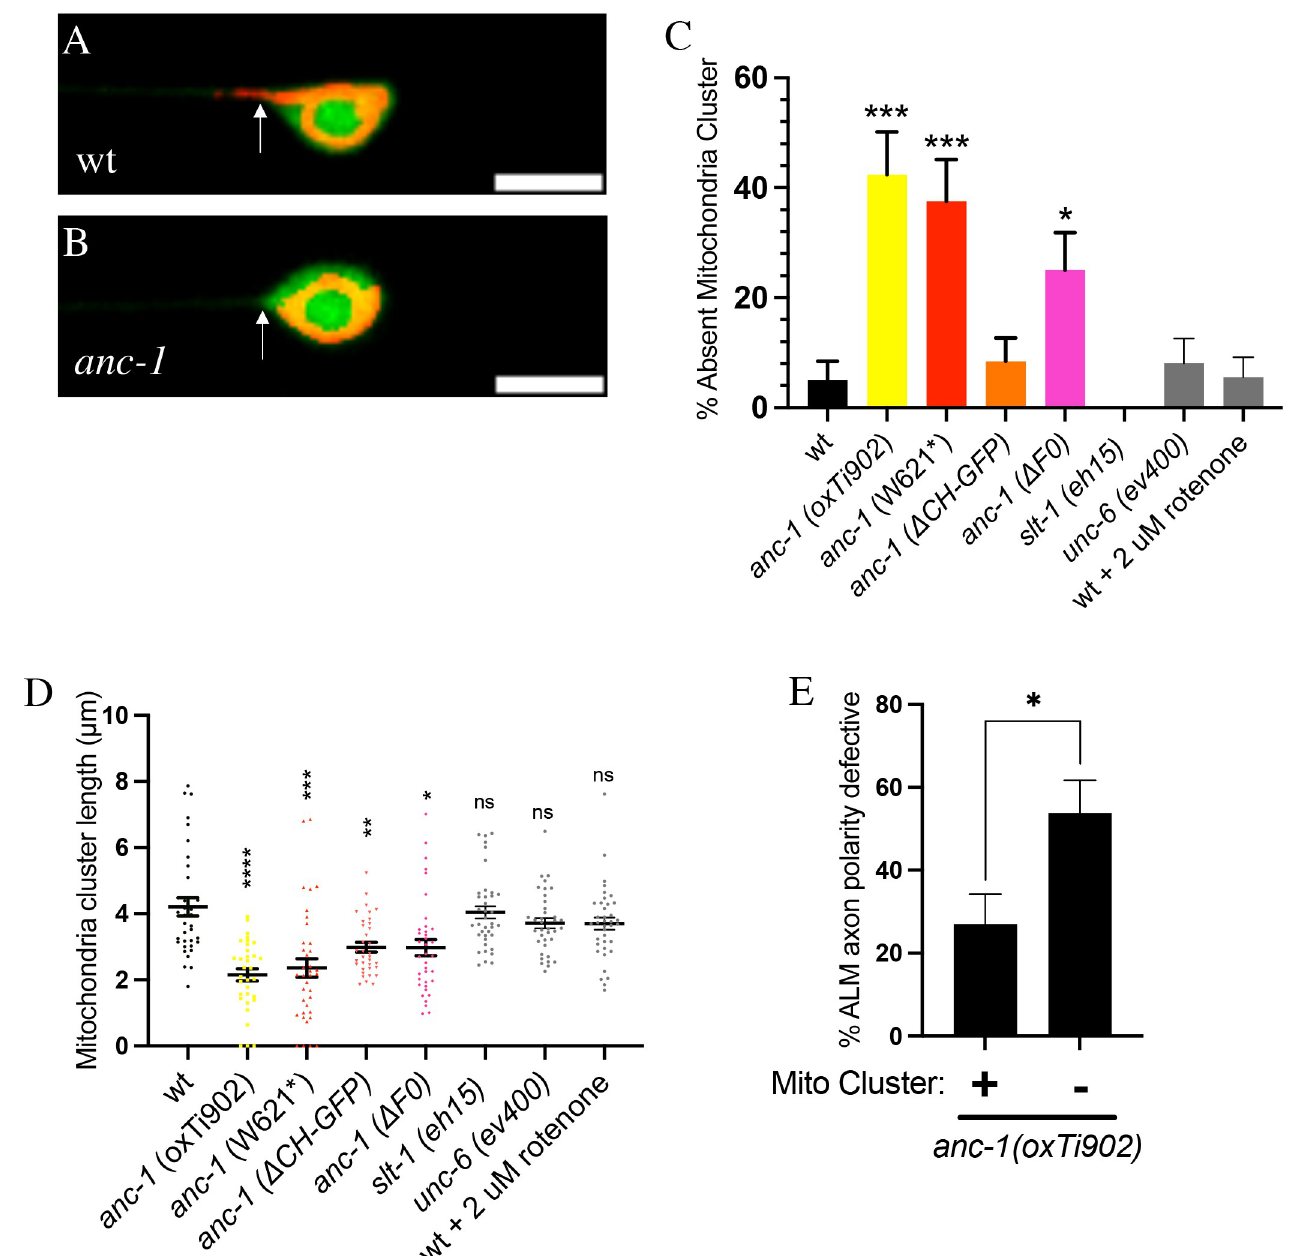
Fig 4. ANC-1A and ANC-1C promote clustering of mitochondria at the base of the proximal axon. (A-B) Example of ALM neurons with wildtype shown in (A) and the anc-1(oxTi902) null mutant shown in (B). Mitochondria are shown in red and are labeled with the mitochondrial targeting sequence of COX8 fused to TagRFP (MITO::TagRFP), which was expressed from the jsIs1073 transgene ( Pmec-7 :: mito :: tagRFP ).The green label is cytosolic GFP, which was used to visualize the entire neuron and was expressed from the muIs32 transgene (Pmec-7 :: gfp ). Scale bars are 5 μ m. (C) Quantification of mitochondrial clustering defect at the base of the proximal ALM axon. N > 35 for all genotypes. Asterisks indicate statistically significant difference, “N-1” Chi-squared test for proportions ( � p = .016, ��� p < .001). Error bars represent the standard error of the proportion. Data displayed as mean ± SEP. (D) Quantification of the length of the mitochondria cluster at the base of the proximal axon. N > 35 for all genotypes. Data was compared using Welch’s ANOVA and Dunnet’s T3 multiple comparisons tests. Asterisks indicate statistically significant difference, ( � p = .011, �� p < .01, ��� p < .001, ���� p < .0001). Data displayed as mean ± SEM (E) Correlation between absence of mitochondria at the base of the proximal axon and the ALM axon polarity phenotype. Asterisk indicate statistically significant difference, “N-1” Chi-squared test for proportions ( � p = .017). Data displayed as mean ± SEP.